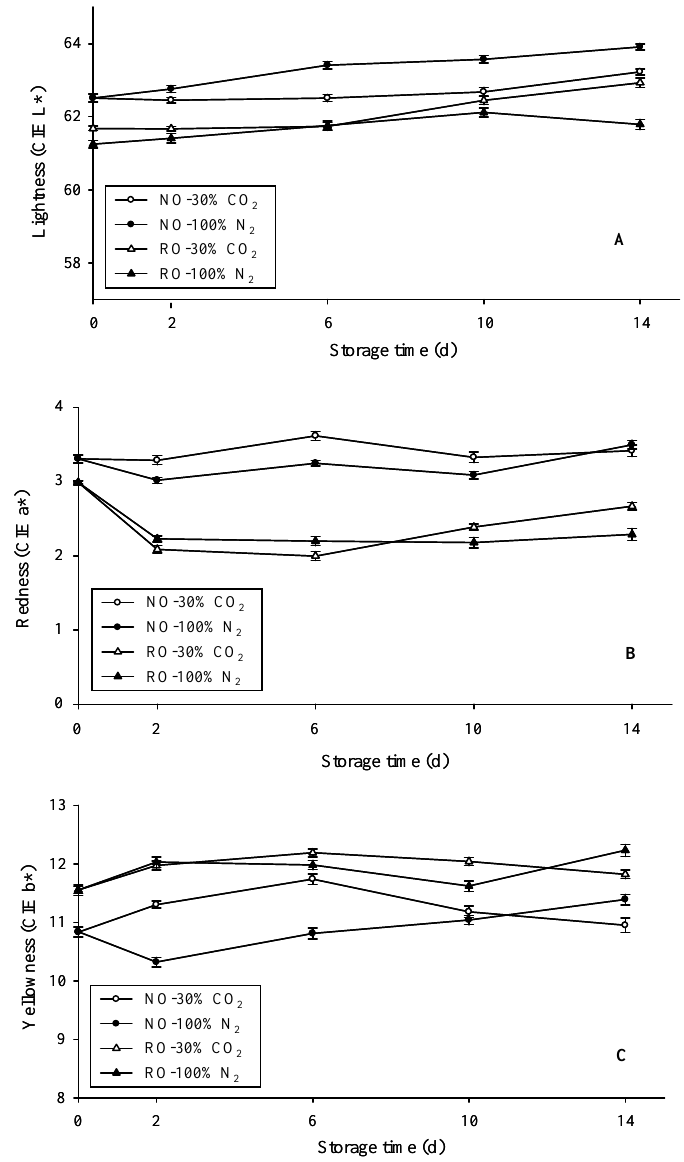
Figure 1. The effect of MAP and addition of rosemary extract, sodium acetate and calcium lactate mixture on instrumental color of lightness (CIE L* value; A), redness (CIE a* value; B), and yellowness (CIE b* value; C) of pre-cooked hamburger patties during refrigerated storage (n = 30). NO-30% CO 2 : Hamburger patties without additive mixture packed with 30% CO 2 +70% N 2 . NO-100% N 2 : Hamburger patties without additive mixture packed with 100% N 2 . RO-30% CO 2 : Hamburger patties with added 500 ppm of rosemary extract, 3,000 ppm of sodium acetate and 1,500 ppm of calcium lactate packed with 30% CO 2 +70% N 2 . RO-100% N 2 : Hamburger patties with added 500 ppm of rosemary extract, 3,000 ppm of sodium acetate and 1,500 ppm of calcium lactate packed with 100% N 2